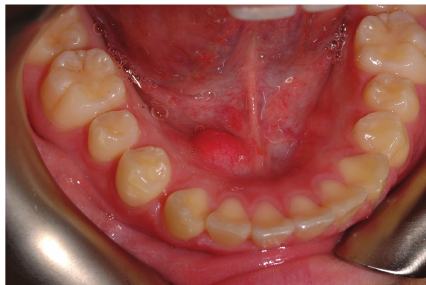
Figure 1: Intraoral submucosal lesion on the right side of the floor of the mouth of a 15-years-old girl, diagnosed with cellular neurothekeoma after biopsy.